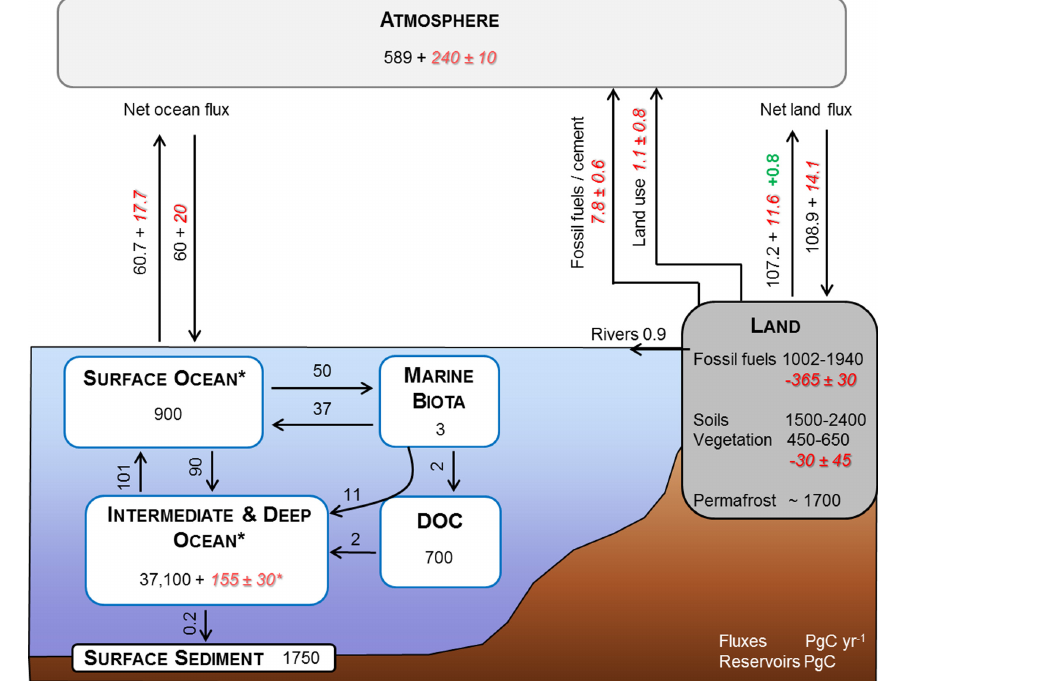
Figure 6. Simplified illustration of the global carbon cycle, adapted from Ciais et al. (2013). Reservoir mass numbers and annual exchange fluxes are given in PgC (10 15 gC) and PgCyr − 1 , respectively. Black numbers refer to pre-industrial values (before 1750). Red flux num- bers represent annual anthropogenic fluxes averaged over the years 2000–2009 and red reservoir numbers depict cumulative changes of anthropogenic carbon between 1750 and 2011 (90% confidence interval). A positive cumulative change denotes an increase in (gain of) car- bon since the onset of the Industrial Era. Land–atmosphere carbon fluxes caused by rock weathering, volcanism and freshwater outgassing amount in total to a flux of 0.8PgCyr − 1 and are represented by the green number. Purely land-based processes like further rock weathering, burial and export from soils to rivers are not depicted in the scheme above. The star ( ∗ ) indicates that the given accumulation number refers to a combined value for Surface Ocean and Intermediate and Deep